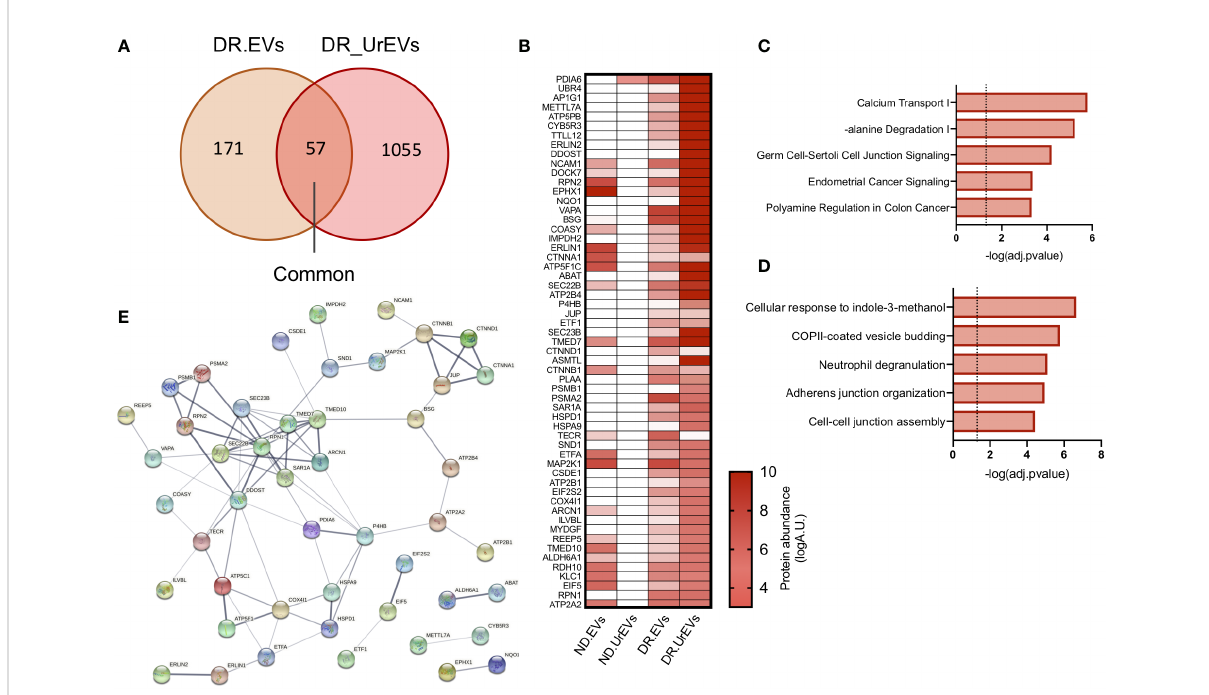
FIGURE 4 Urine EVs contain proteins observed in retinal EV from DR patients. (A) Venn diagrams comparing proteome from DR retina tissue derived EVs and DR Urinary EVs. (B) Heatmap of 57 common proteins showing expression in left to right, Nondiabetic retinal tissue derived EVs (ND. EVs), Non diabetic Urinary EVs (ND.UrEVs), Diabetic retinopathy retinal tissue derived EVs (DR.EVs) and Diabetic retinopathy Urinary EVs (DR.UrEVs). Pathway (C) and biological process (D) enrichment analysis of 57 common proteins found in urinary and retinal EVs from DR patients. (E) STRING protein-protein interaction networks of common protein observed in EVs from DR patients.